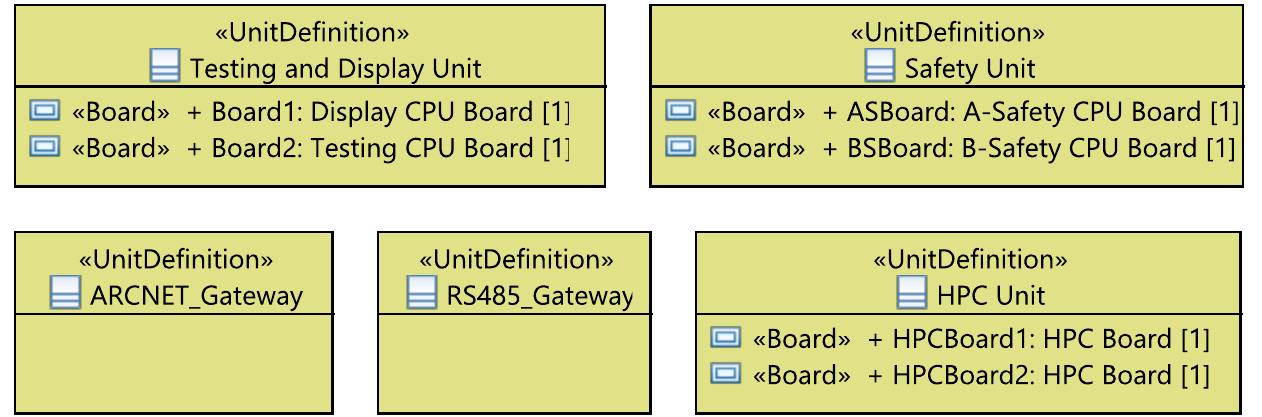
Figure 19. Units on the rack.